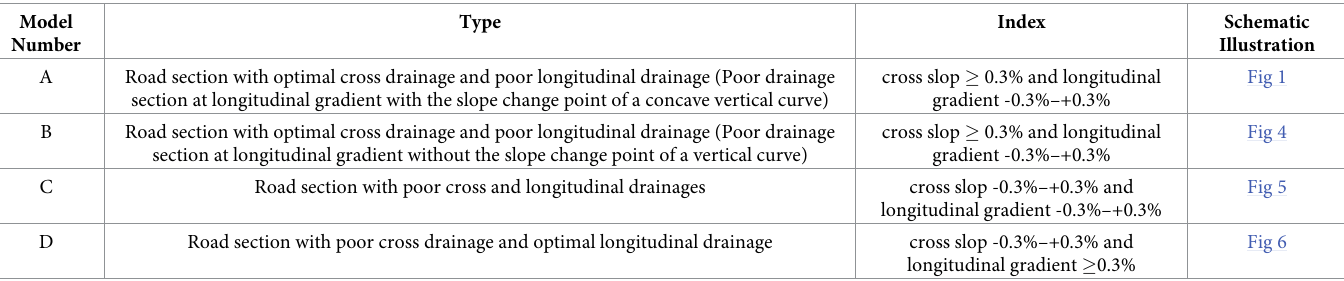
Table 1. Geometric models of road water accumulation.